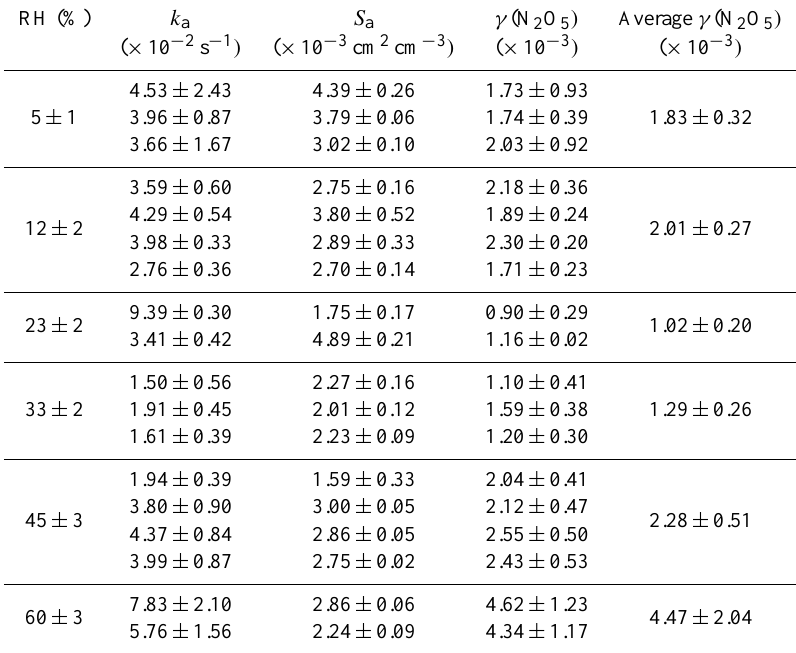
Table 1. Loss rate of N 2 O 5 on TiO 2 ( k a ) , total surface area of TiO 2 particles in the flow tube ( S a ) and uptake coefficients of N 2 O 5 onto TiO 2 aerosols, γ (N 2 O 5 ) at different relative humidities. All the errors shown here are 1 σ